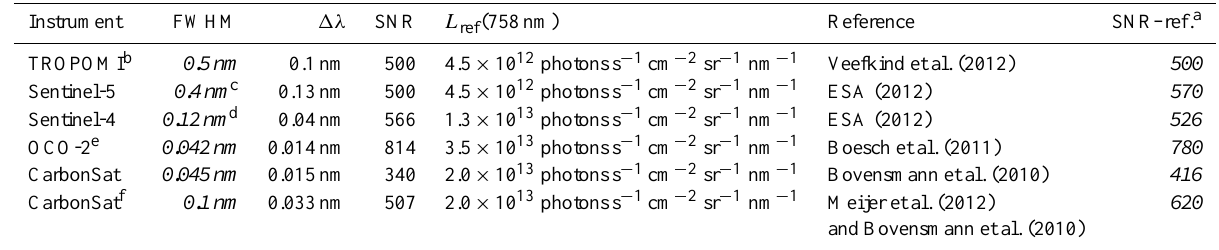
Table 3. Instrument specifications of the O 2 A band channel for a number of space-borne grating spectrometers that will be operational in the coming years. Numbers printed italic can be used to interpret Fig.